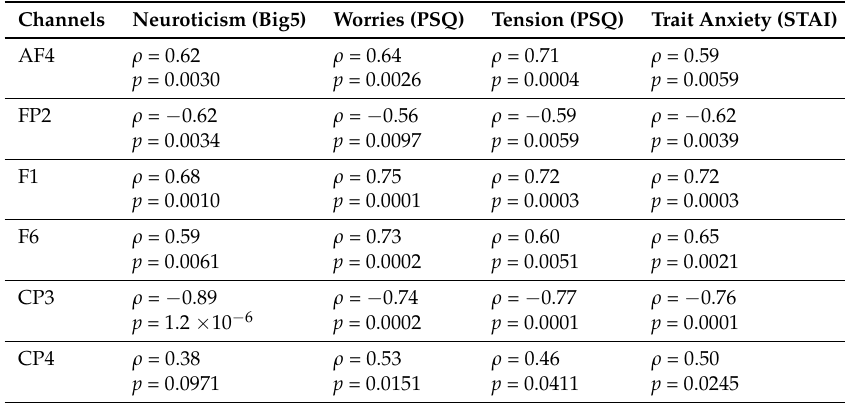
Figure A13. Eyes-Closed (EC) setting. Spearman correlation between participants’ responses to questionnaires and their cumulative TEs. These TEs correspond to EEG channels whose cumulative TEs were significantly different between HIGH versus LOW stress-susceptible participants. Those channels were: AF4, FP2, F1, F6, CP3, CP4, P2, P3, and O2. They are marked along the vertical axis of each subplot in the figure. The questionnaires are marked on the top of each subplot and along their horizontal axis. Table A12. Eyes-closed (EC) setting. Paired Spearman correlations between participants’ cumulative TEs and their responses to questionnaires. The cumulative TEs are associated with the EEG channels whose cumulative TEs were significantly different between HIGH and LOW stress-susceptible groups. These channels were AF4, FP2, F1, F6, CP3, CP4, P2, P3, and O2. The questionnaires were: neuroticism (Big5), worries (PSQ), tension (PSQ), and trait anxiety (STAI). In this figure, the row entries associated with each of these EEG channels are marked along the figure’s vertical axis. The questionnaires are marked column-wise and along the horizontal axis and at the top of subplots’ columns. In each subplot, the cumulative TEs are along the x-axis and questionnaires’ responses are along the y-axis. The ρ and p represent the Spearman correlation coefficient and its corresponding p